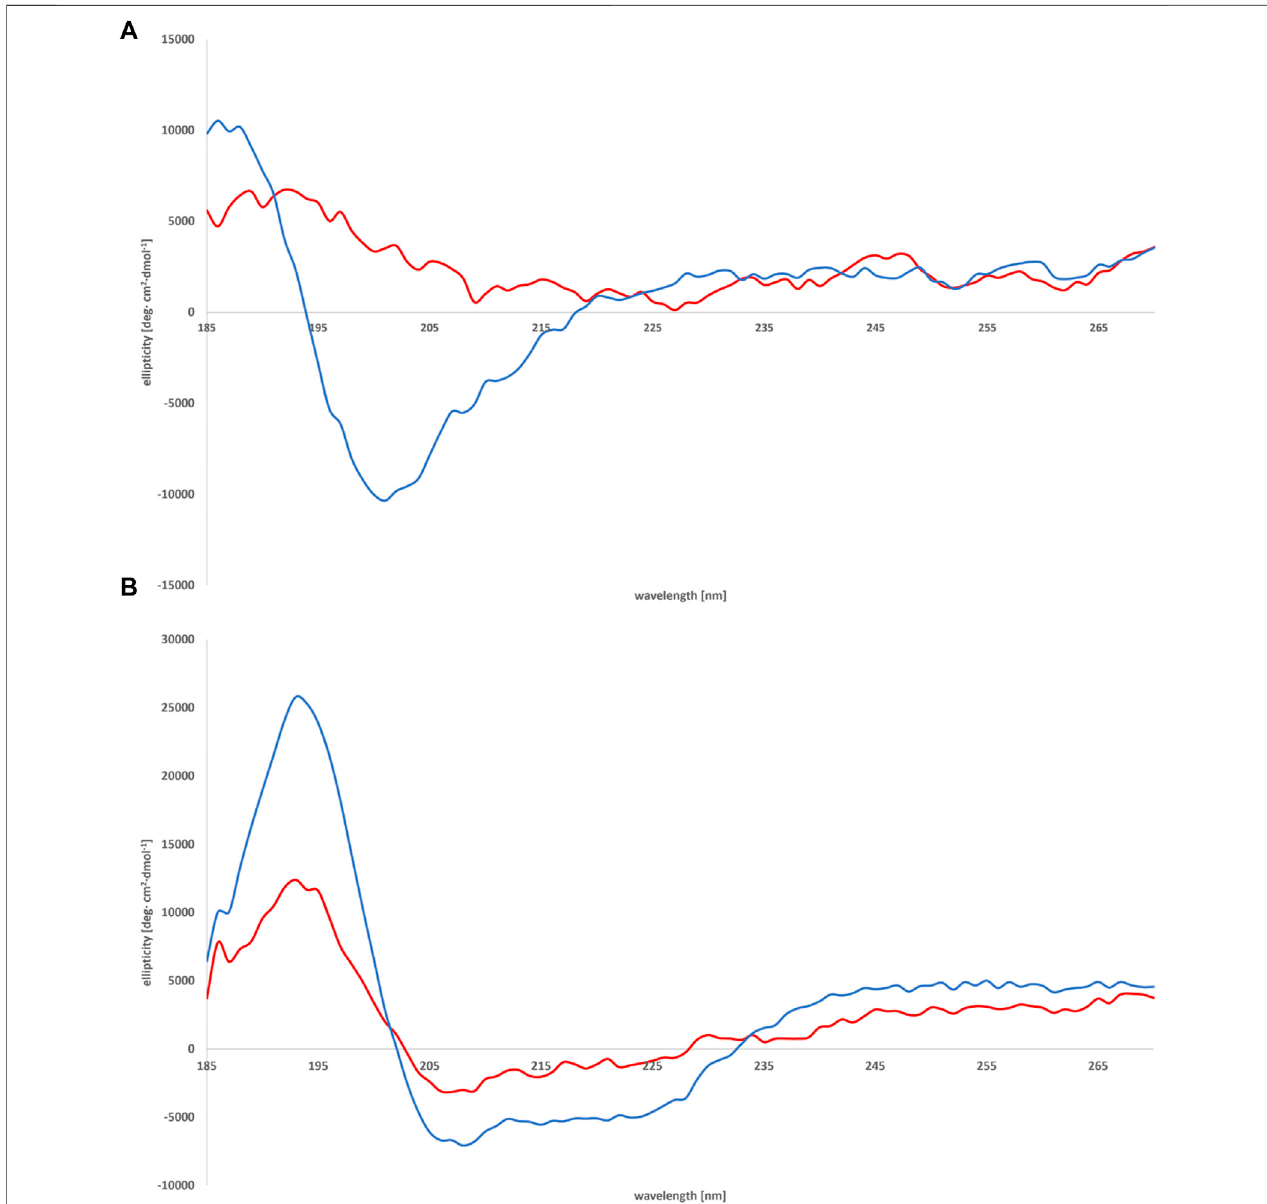
FIGURE 3 | CD spectra of peptides MBP (81 – 106) (1) (blue line) and MBP (76 – 116) (2) (red line) measured in water (A) and mixture of H 2 O:TFE (50:50, v:v) (B) at 25 ° C.